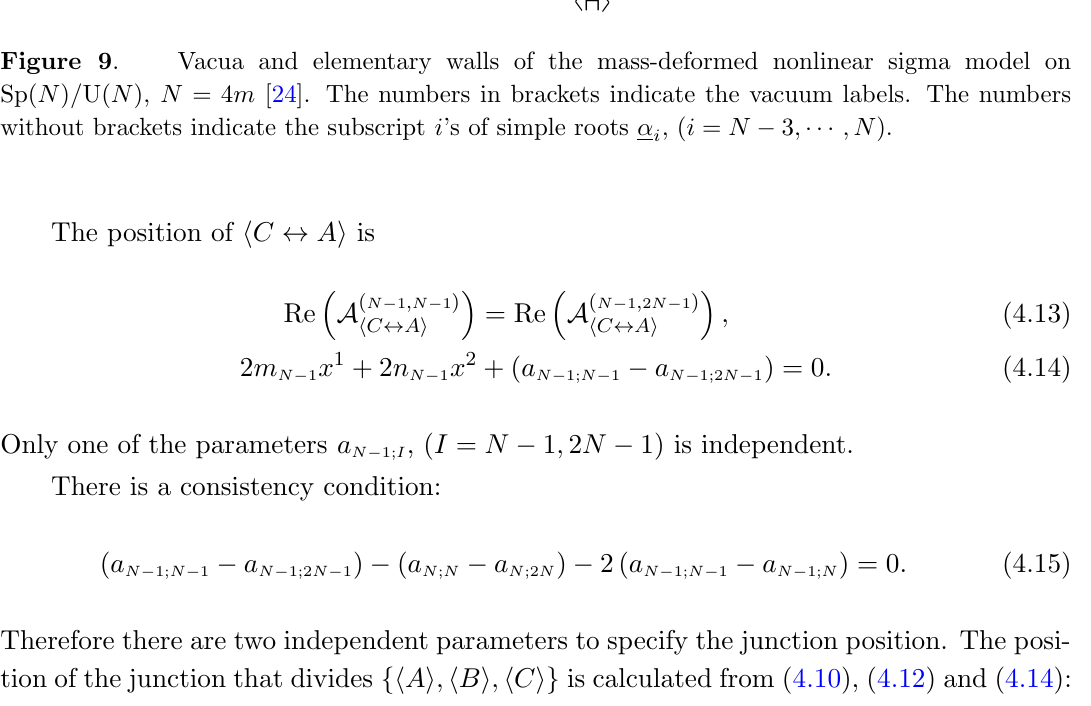
The position of h C $ A i